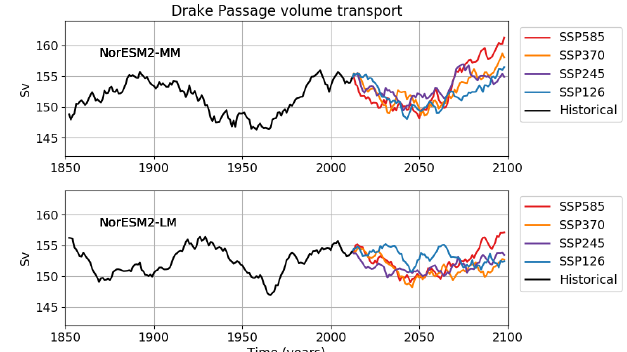
Figure 7. As in Figs. 5 and 6 but for the time evolution of trans- port due to the Antarctic Circumpolar Current through the Drake Passage.